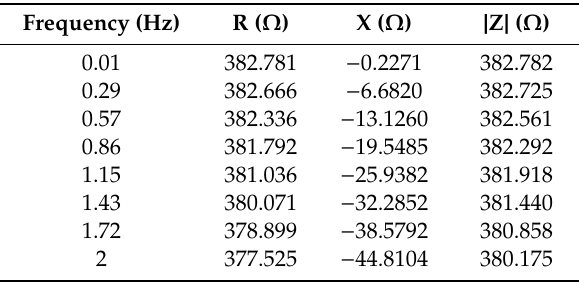
Table 2. Output impedance obtained by SPICE for different frequencies.